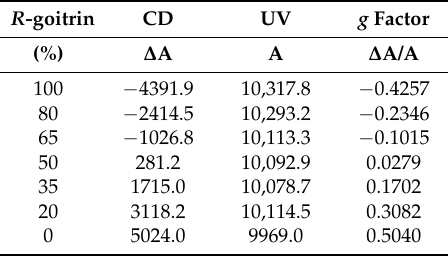
Table 3. The results of precision, repeatability, stability, and recovery for five analytes.